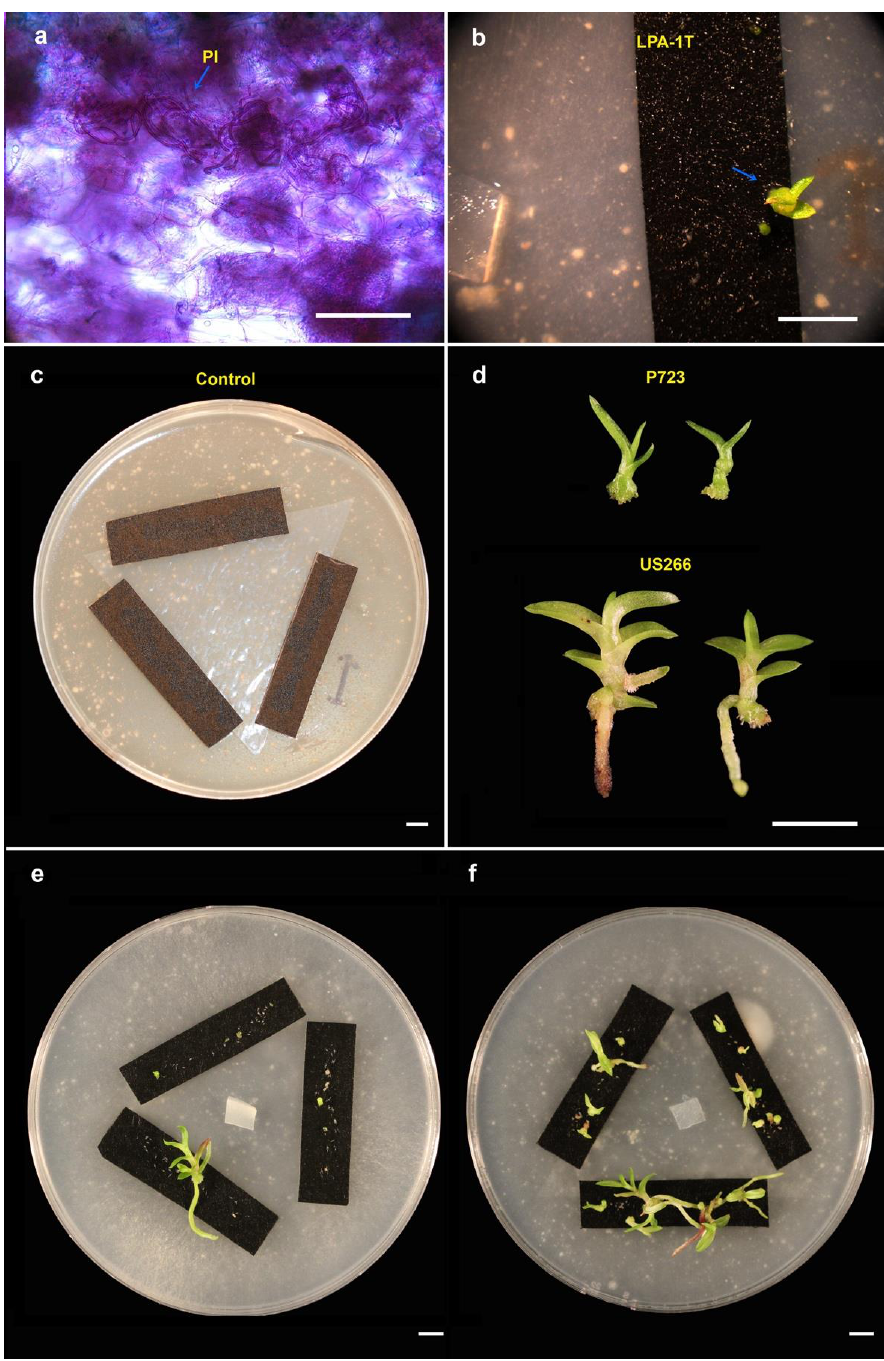
Figure 2. Symbiotic seed culture of E. geminiflorum. ( a ) Peloton (Pl) formation in root cortical tissue of E. geminiflorum seedlings co-cultured with US266. ( b ) Seedling (blue arrow) growing with LPA1T after 42 wks. ( c ) Control symbiotic plate with a cellophane membrane and black filter paper strips on solidified agar OMA. ( d ) Seedlings growing on P723 or co-cultured with US266. ( e ) Seedling co- cultured with US266 after 42 wks under complete darkness for 6 wks and ( f ) 42 wks under 12 h- light photoperiod. Scale bars = 500 µm ( a ) and 5 mm ( b – f ).